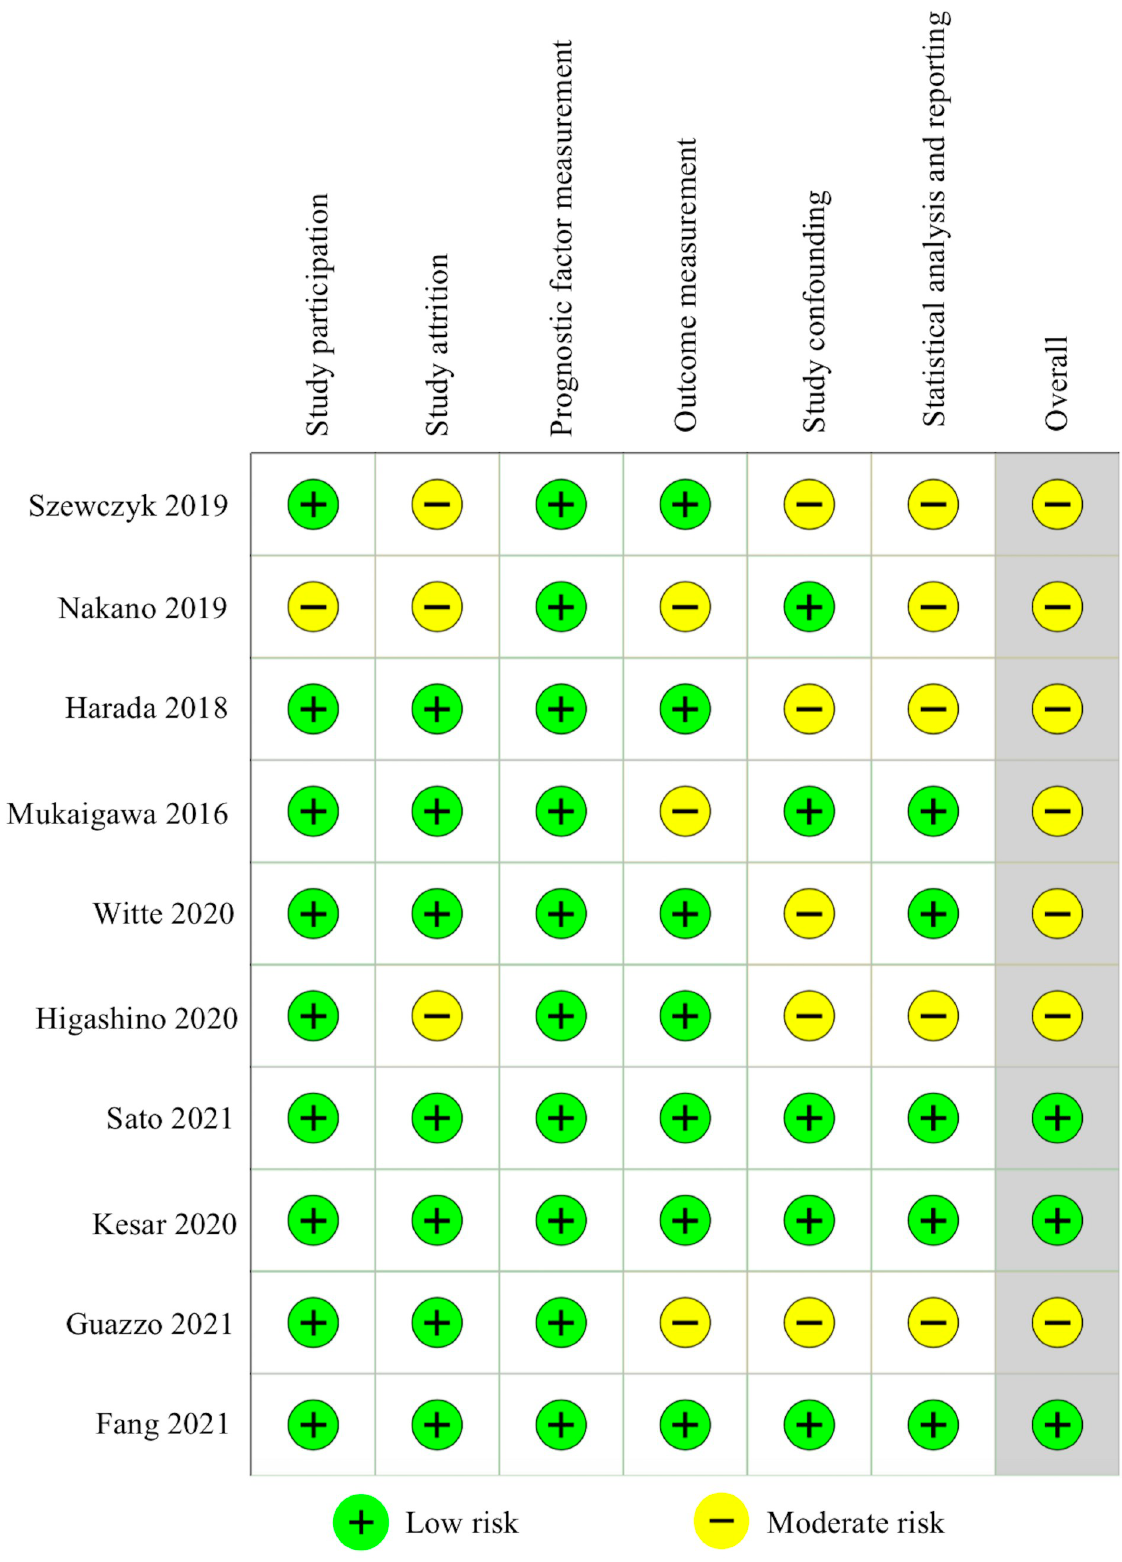
Fig 2. Risk of bias assessment using the Quality In Prognosis Studies (QUIPS) tool.